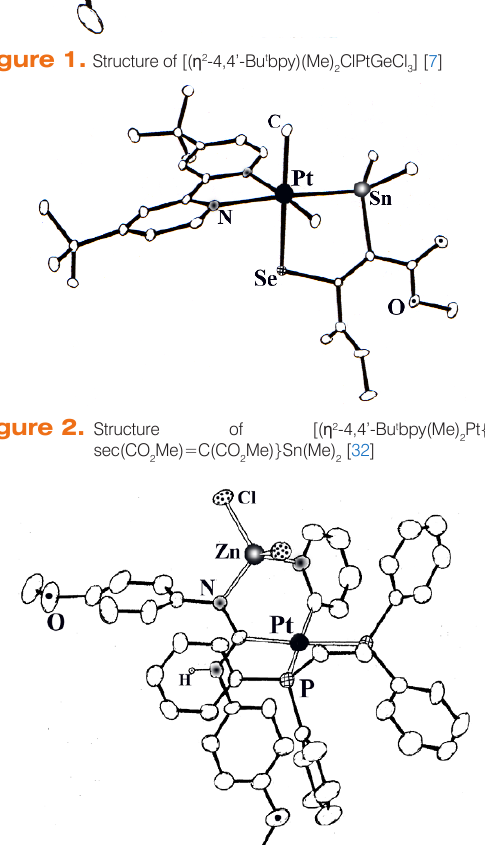
Figure 1. Structure of [( η 2 -4,4’-Bu t bpy)(Me)